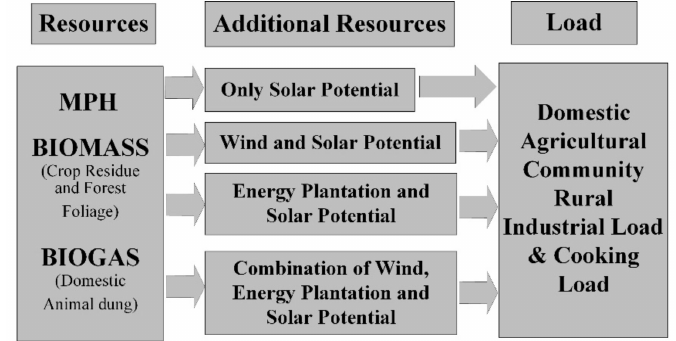
Figure 5. Different energy scenarios, depending on the study area. Reported by Uttarakhand, India. Reproduced with permission from [36], [Renewable Energy], published by [Elsevier], [2010].